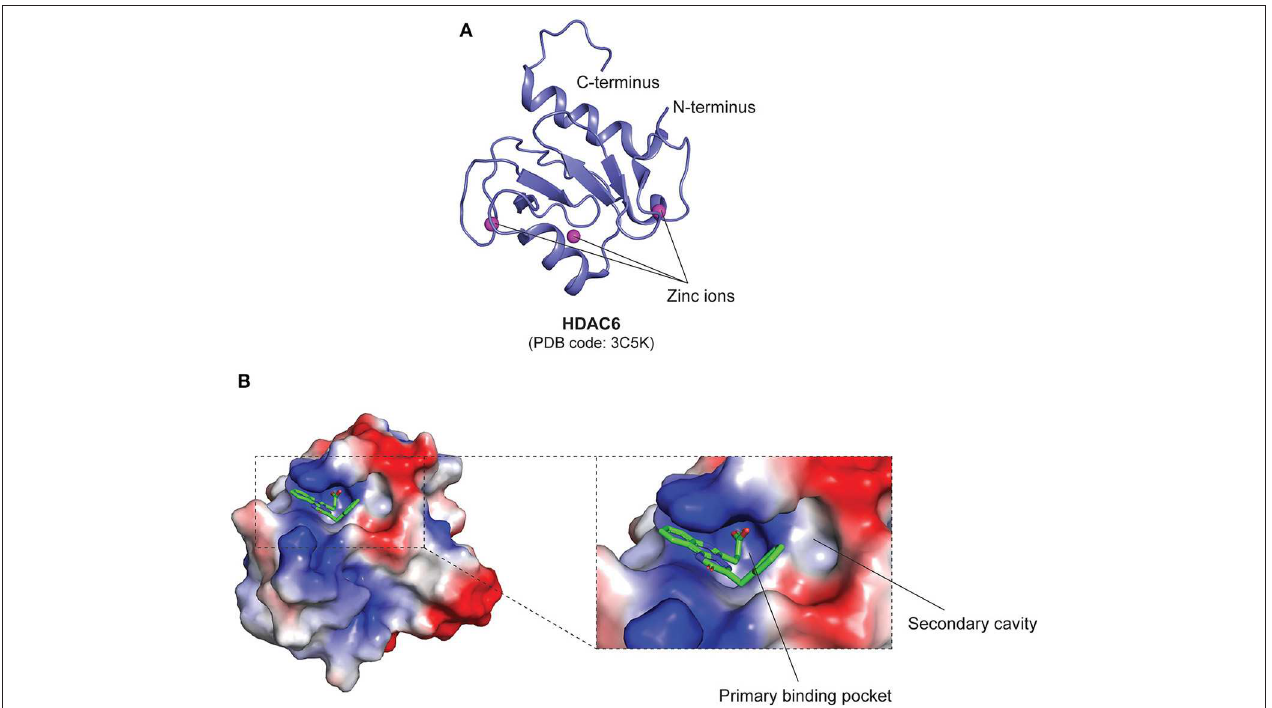
FIGURE 6 | Structural features of the class IIb HDAC, HDAC6 ZnF-UBD. (A) Overall structure of the ZnF-UBD of HDAC6 (PDB code: 3C5K ). (B) Surface representation of inhibitor-bound human HDAC6 ZnF-UBD (PDB code: 5WBN ). The electrostatic potential map shows the inhibitor-bound primary binding